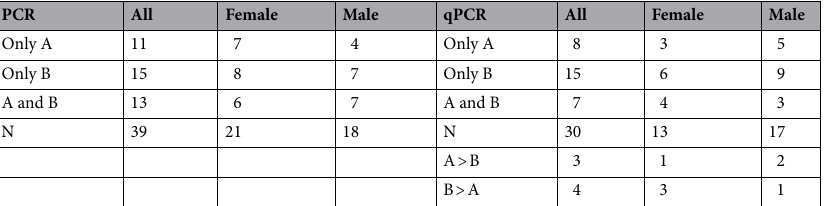
Table 1. Detection of the two mitogenomes (A and B) by PCR and qPCR. Number of tested individuals (N) in which A or B mitogenome was detected. For qPCR, each heteroplasmic individual showed an excess of one mitogenome over the other, which is also indicated here for mantle